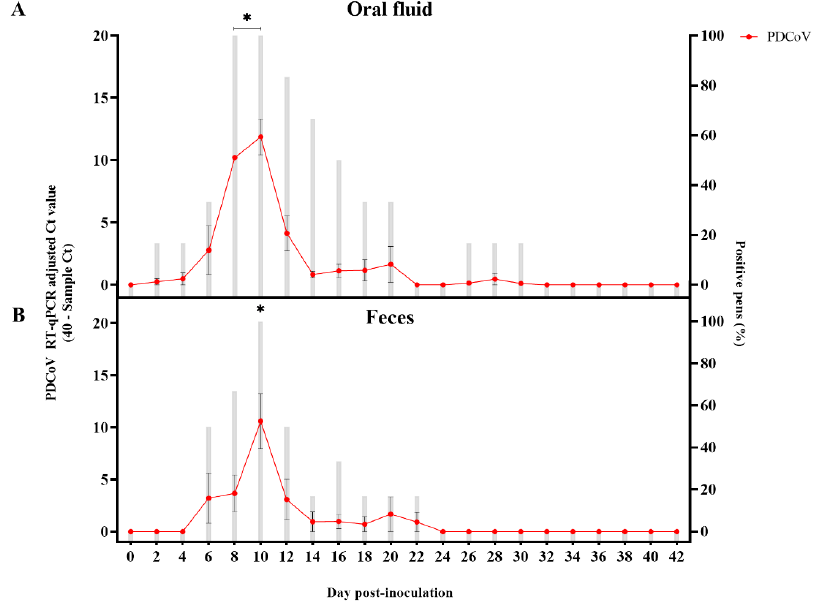
Figure 2. Detection of porcine deltacoronavirus (PDCoV) RNA in pen-based oral fluids ( n = 6) and fecal ( n = 6) samples collected every other day between day post-inoculation (DPI) 0 to 42 from PDCoV- and mock-inoculated 7-week-old grower pigs using a commercial porcine enteric coronaviruses multiplex RT-qPCR (EZ-PED/TGE/PDCoV MPX 1.1 (Tetracore Inc.) specific for porcine epidemic diarrhea virus (PEDV), transmissible gastroenteritis virus (TGEV) and PDCoV. This graph represents the average data of 40-sample Ct values on the left y -axis (line chart with markers), while the average percentage of positive pens were shown on the right y -axis (bar-graph). Samples with Ct values above 40 were considered negative. ( A ) Detection in pen-based oral fluid samples; ( B ) Detection in pen-based fecal samples. Error bars represent the standard error of the mean (SEM), and * denotes statistical significance ( p <